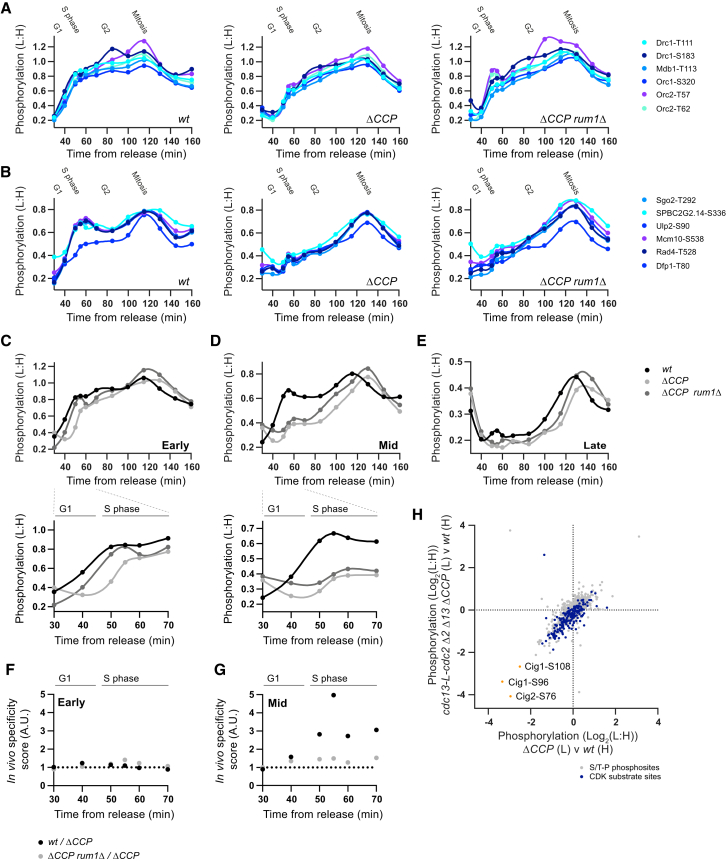
Comparative Analysis with Wild-Type Cells Expressing Multiple Cyclin-CDK Complexes(A and B) The relative phosphorylation of individual (A) early and (B) mid CDK substrate sites, after release from G2 arrest, in wild-type cells (wt) and cells deleted for G1/S cyclins (ΔCCP and ΔCCP rum1Δ). Spline connects points. Imputation to replace missing values and data smoothing were applied. NB sites in Rad4 and Dfp1 were redefined as mid substrates after visual inspection of the data.(C–E) The median relative phosphorylation of early, mid, and late CDK substrate sites after release from G2 arrest in wt (C), ΔCCP (D), and ΔCCP rum1Δ (E) cells.(F and G) Plot of the G1/S cyclin specificity score for (F) early and (G) mid substrates.(H) The relative phosphorylation of all detected S/T-P phosphosites (n = 1279) (gray), including CDK substrate sites (n = 170) (dark blue), and G1/S cyclin phosphosites (orange) in ΔCCP and cdc13-L-cdc2 Δ2 Δ13 ΔCCP cells during S-phase arrest. Sites for which 0.5 > L:H > 2 in a wt versus wt control were excluded.See also Figure S7. See Figures S7A and S7E for experimental design. See STAR Methods for G1/S cyclin-specificity score calculation.